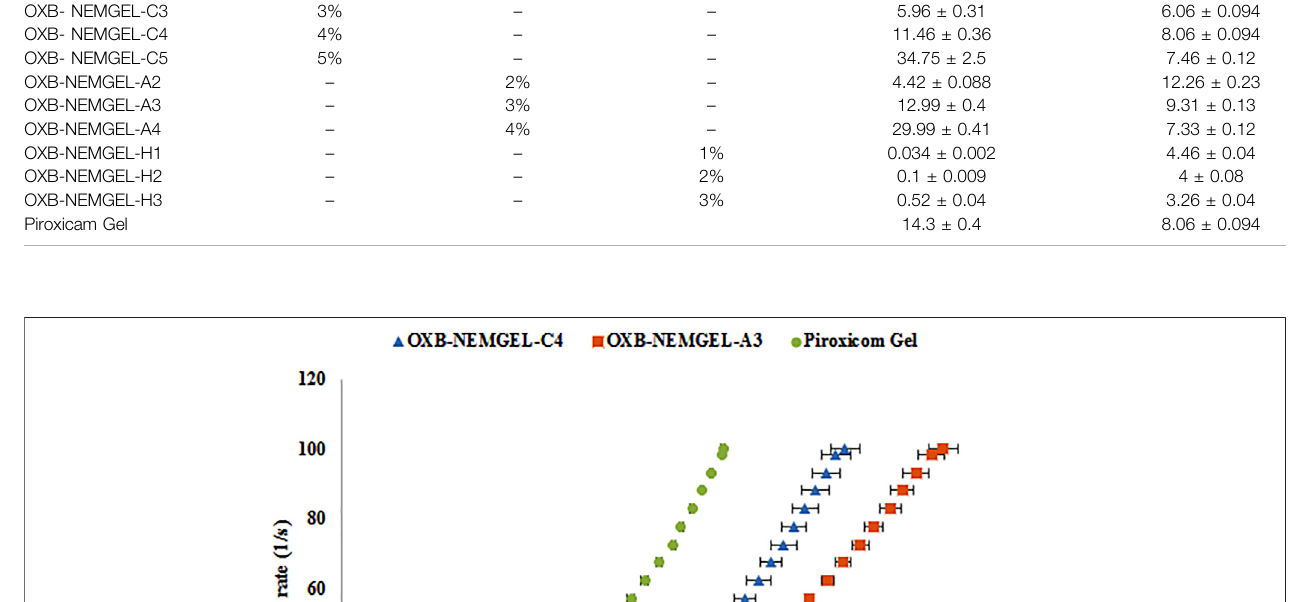
TABLE 3 | OXB-NEMGEL formulations viscosity and spreadability results (Concentrations w/w%). Formulation